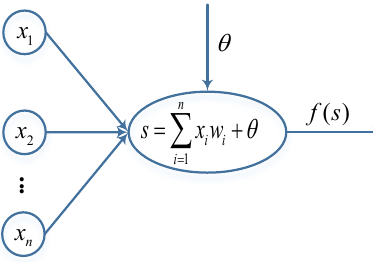
Figure 6. Basic structure of neurons, x represents the input information from the previous layer neurons, ω is the weight, θ is the bias and f ( s ) is the output of the neu- ron.